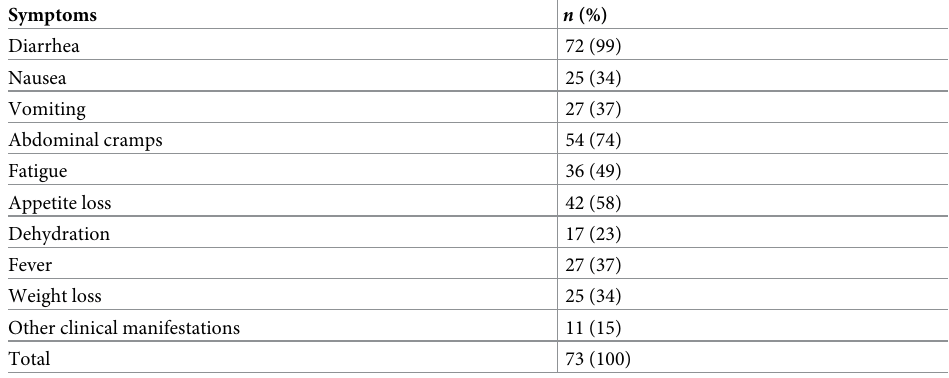
Table 5. Number and percentage of investigated cases by reported symptoms in Que ´ bec, Canada, 2016–2017.